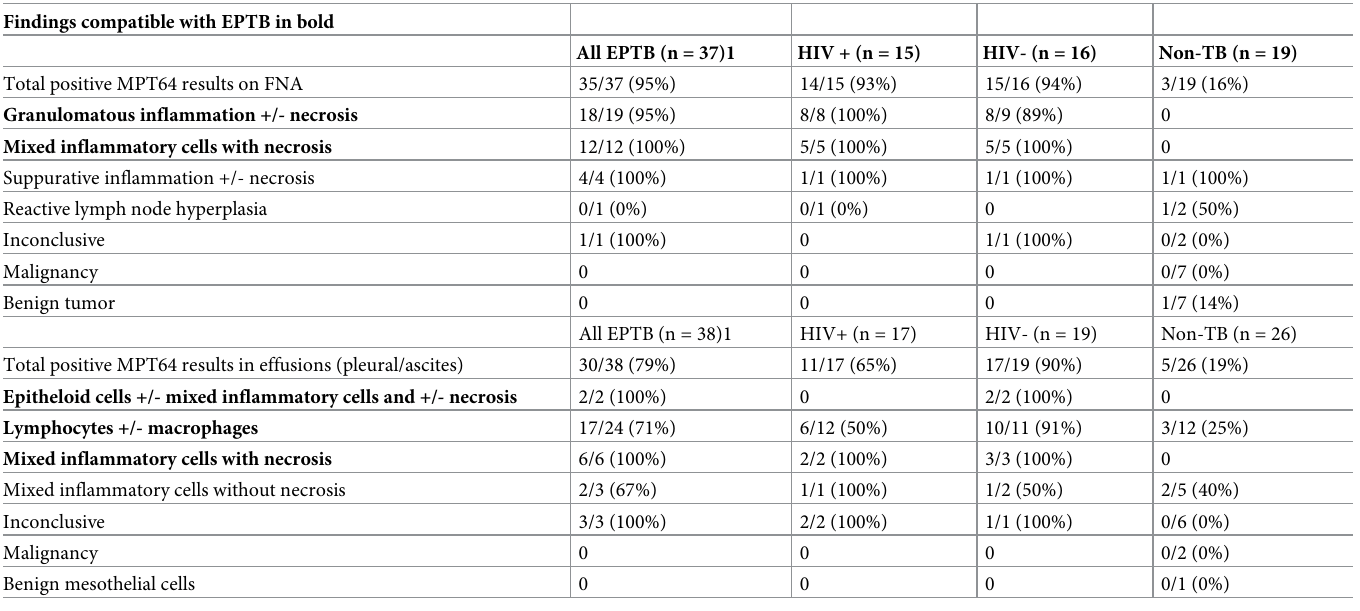
Table 4. Positive MPT64 test results and their correlation to findings on FNAC and cytological findings in effusions (n = number of MPT64 samples). Findings compatible with EPTB in